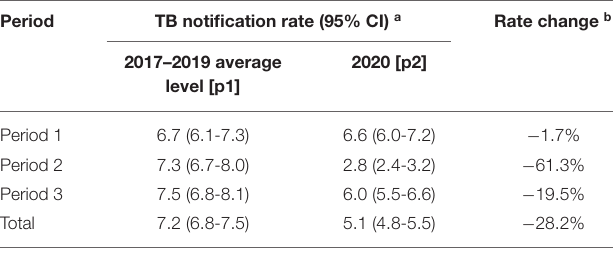
TABLE 2 | Comparison of TB notification rate breakdown by three periods between 2020 and 2017–2019 average